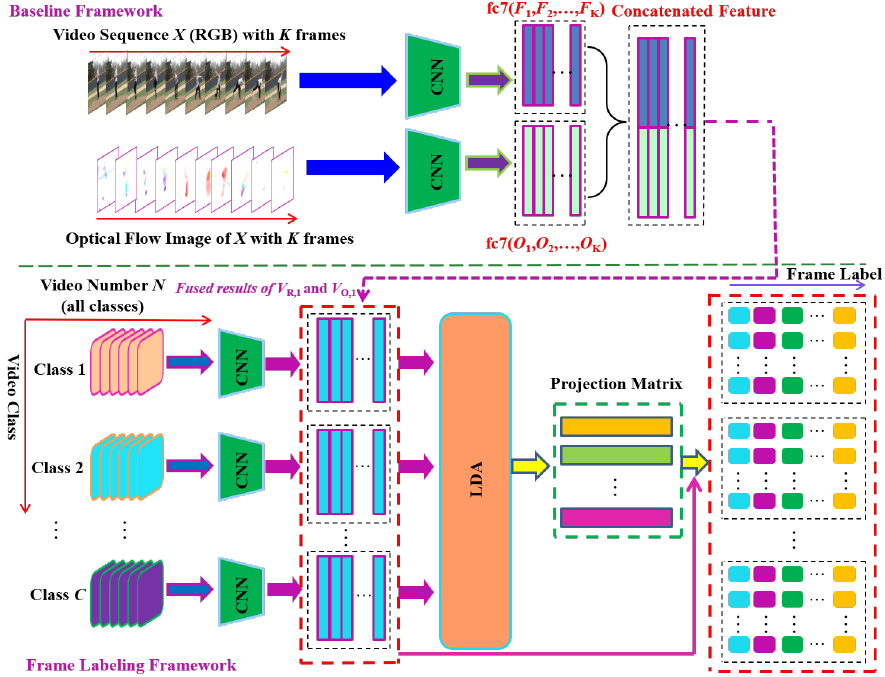
Figure 3. Block Diagram. Automatically generating labels to train the deep key frame automatic annotation framework. The appearance and motion information (the output of fc7 layer of VGG-16 [58]) are concatenated as a spatio-temporal feature vector. Thereon, LDA is applied to all the feature vectors of all the classes of training videos to project the feature vectors to a low dimensional feature space (LDA space) and obtain the projection vectors of each class videos. Finally, the projection vectors are used to calculate the frame-level video